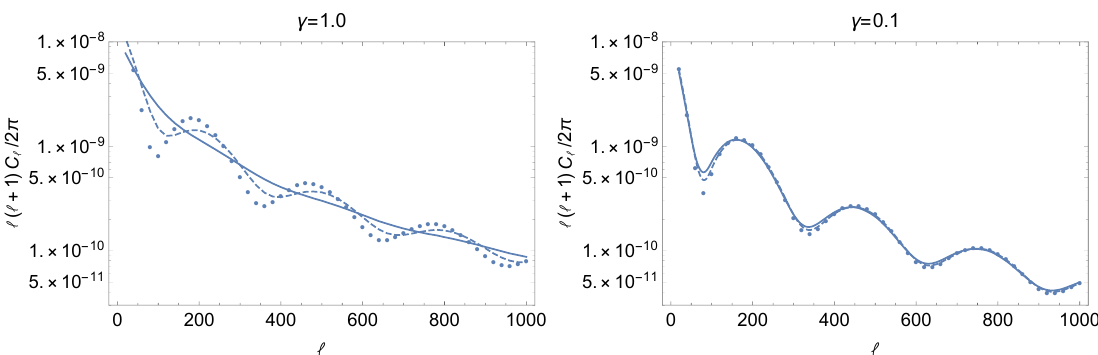
Figure 4. The anguler power spectrum of CMB fluctuations by PGWs with the decoherence effect (left panel: γ = 1.0 and right panel: γ = 0.1). The different curves correspond to (cid:101) = 0.5 (dotted line), (cid:101) = 1.0 (dashed line) and (cid:101) = 1.5 (solid line).